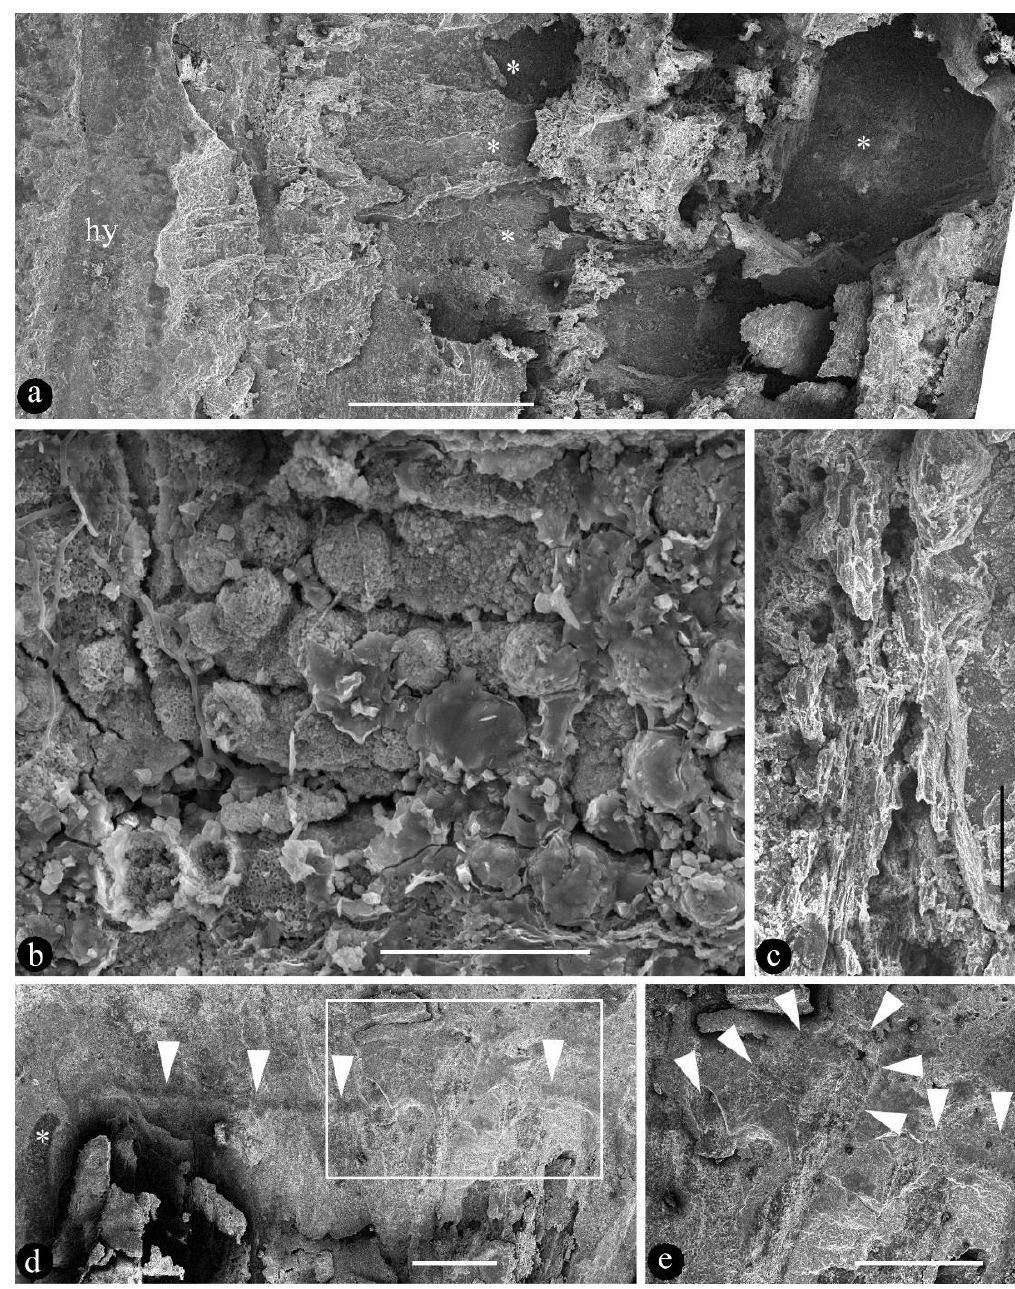
Figure 4. SEM views of Lingyuananthus inexpectus gen. et sp. nov. ( a ) A portion of the interior of the ovary showing hypanthium (hy) and cavities (asterisks) left by several ovules. Scale bar = 1 mm. ( b ) Papillae on the dislocated ovule shown in Figure 2c,d. Scale bar = 50 μm. ( c ) Transmitting tissue within the ovary. Refer to Figure 2b. Scale bar = 0.1 mm. ( d ) SEM view of the ovary top (triangles). Note one of the lateral appendages (asterisk) to the left. Refer to Figure 3a. Scale bar = 1 mm. ( e ) Detailed view of the rectangular region in Figure 4d showing the process (triangles). Scale bar = 1 mm.